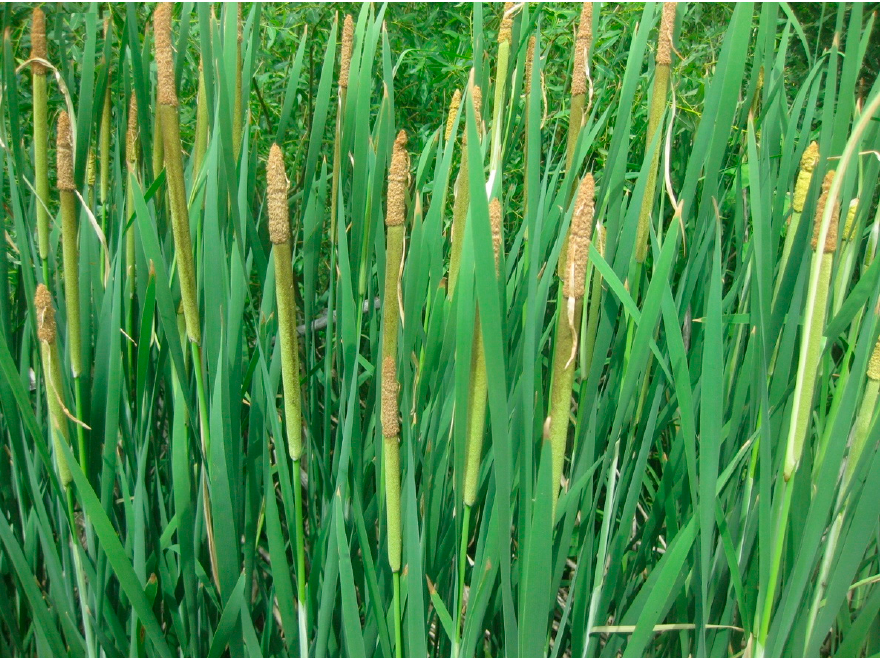
Figure 3. Typha lepechinii sp. nov.: general aspect. Russia, Republic of Bashkortostan, Miyakinsky district; 53°31 ′ 57.70 ″ N, 54°50 ′ 28.73 ″ E; on the damp shore along the stream Kurmanay, 1.9 km from village Kurmanaibash. The female inflorescences are young and green. Photo: A. A. Muldashev.